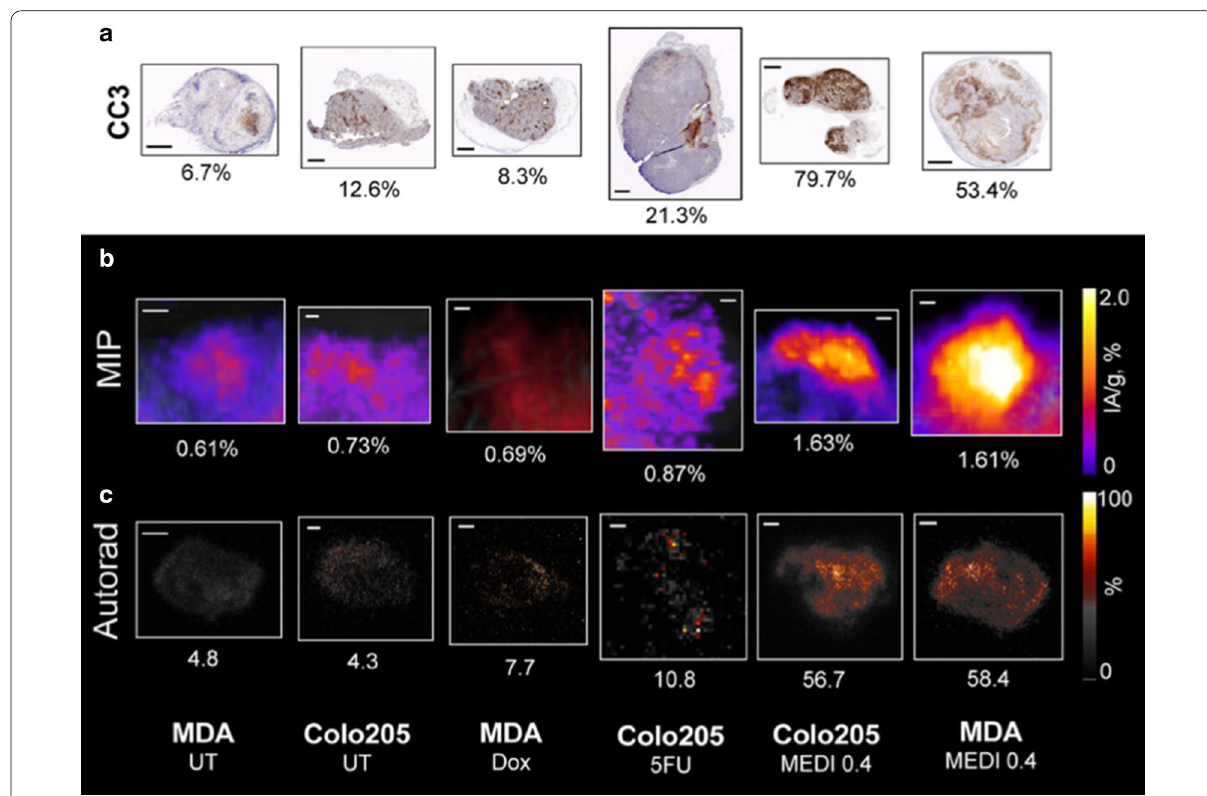
Fig. 8 Correlation of 18 F‑C2A signal with immunohistochemical markers of cell death for representative MDA‑MB‑231 and Colo205 tumors. a Cleaved caspase‑3 (CC3). Tumor section positive CC3 pixel count values (%) are shown. b Maximum intensity projection (MIP) of PET signal (IA/g, %). c Autoradiography of tumor sections acquired immediately after imaging (% of area with signal). Tumors were collected from different mice, bearing either Colo205 or MDA‑MB‑231, 2 h following administration of 18 F‑C2Am. MEDI3039 (MEDI) used at 0.4 mg/kg, i.v., for 24 h. 5FU and Doxorubicin (Dox) were both used at 100 mg/kg, i.p., for 24 h. UT untreated